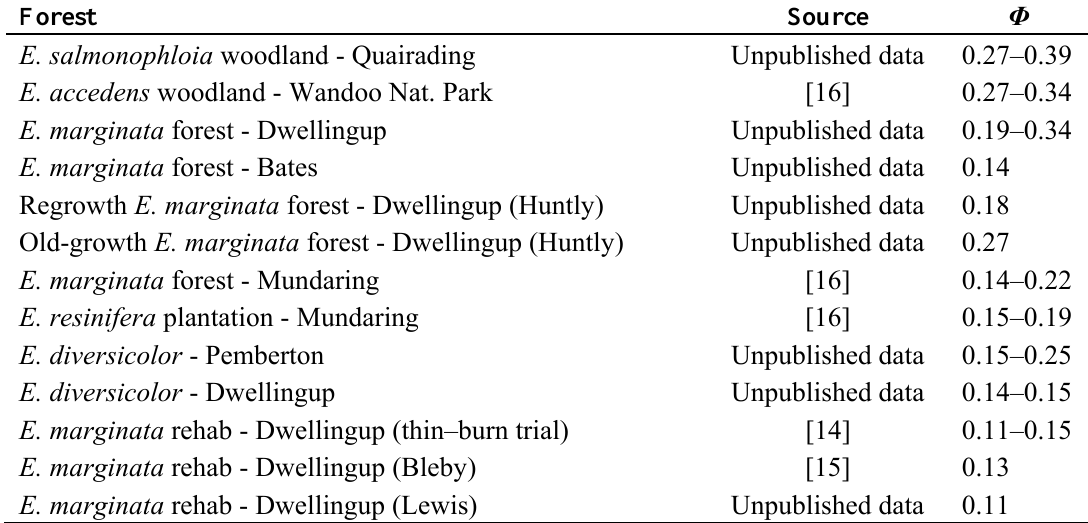
Table 1. Estimates of crown porosity ( Φ ) in eucalypt forest obtained from